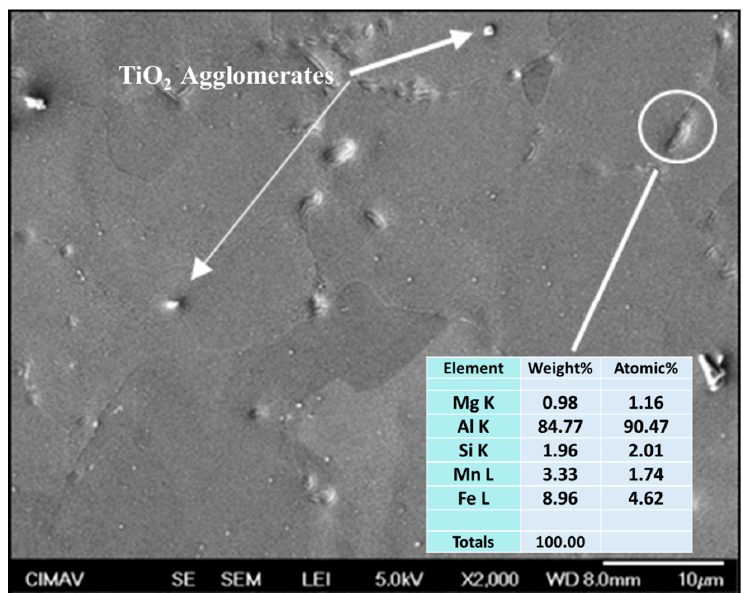
Figure 14. SEM secondary electrons image of the Al/TiO 2 composite.